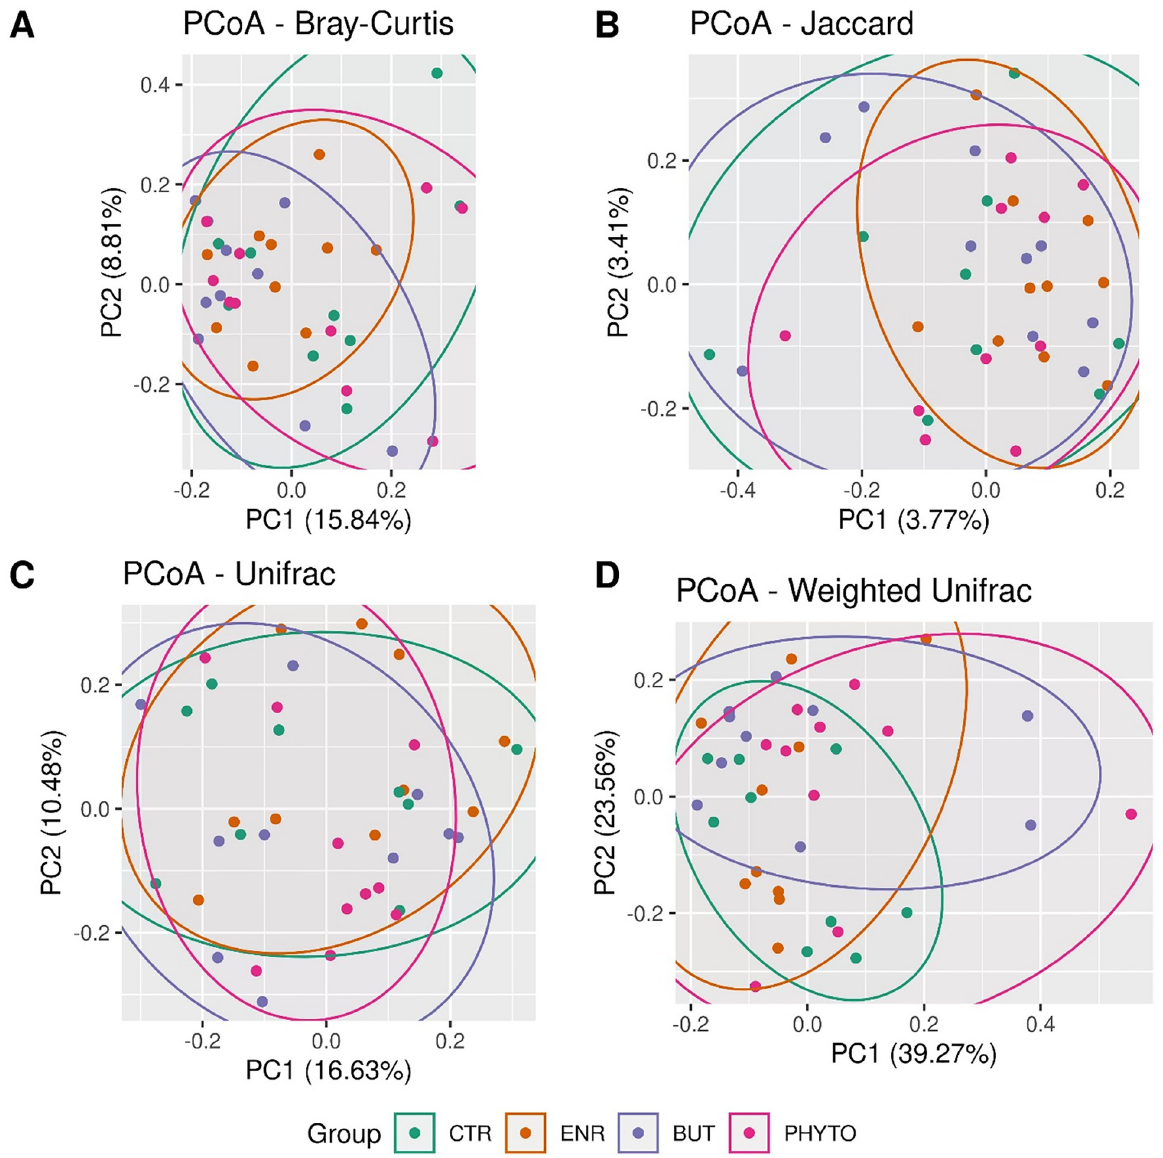
Fig 3. Beta diversity estimated by the parameters Bray-Curtis (A), Jaccard (B), UniFrac (C), and Weighted UniFrac (D). Coloured ellipses were automatically added through the ggforce library in R.